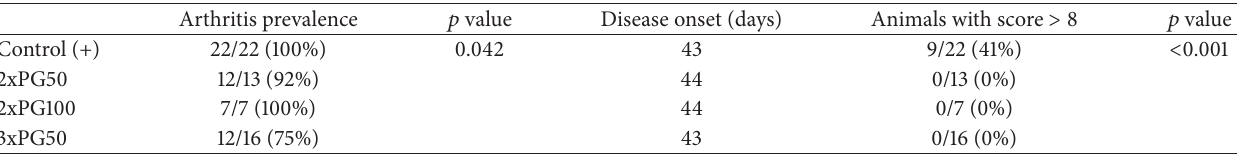
Table 1: Arthritis prevalence and severity in mice previously inoculated with proteoglycan. Arthritis score was daily evaluated and disease severity was assessed by a visual scoring system with total score ranging from 0 to 16 for each animal. Score above eight indicates severe arthritis. These parameters were compiled 70 days after arthritis induction. Control (+): arthritic group not previously injected with PG; 2xPG50, 2xPG100, and 3xPG50: arthritic groups previously injected with two (50 𝜇 g), two (100 𝜇 g), or three (50 𝜇 g) PG doses, respectively. Data from two independent experiments were